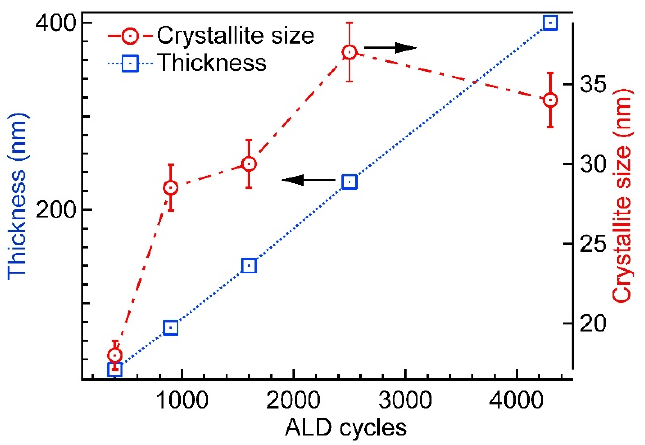
Figure 4. Variation of film thickness and XRD apparent crystallite size (D y ) with the number of deposition cycles for Cr 2 O 3 samples grown at 420 ◦ C.